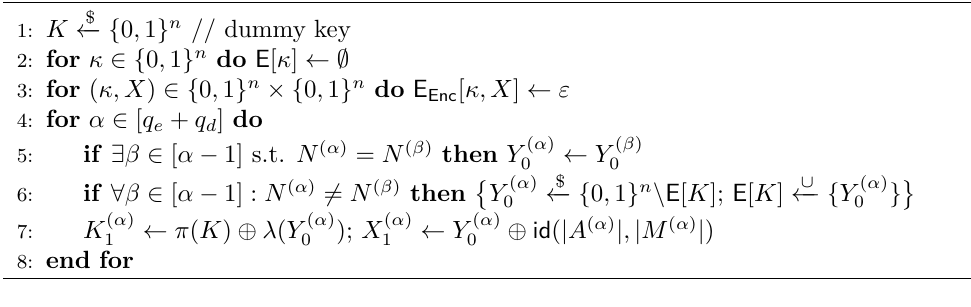
Algorithm 3 Dummy Internal Values for Encryption Queries